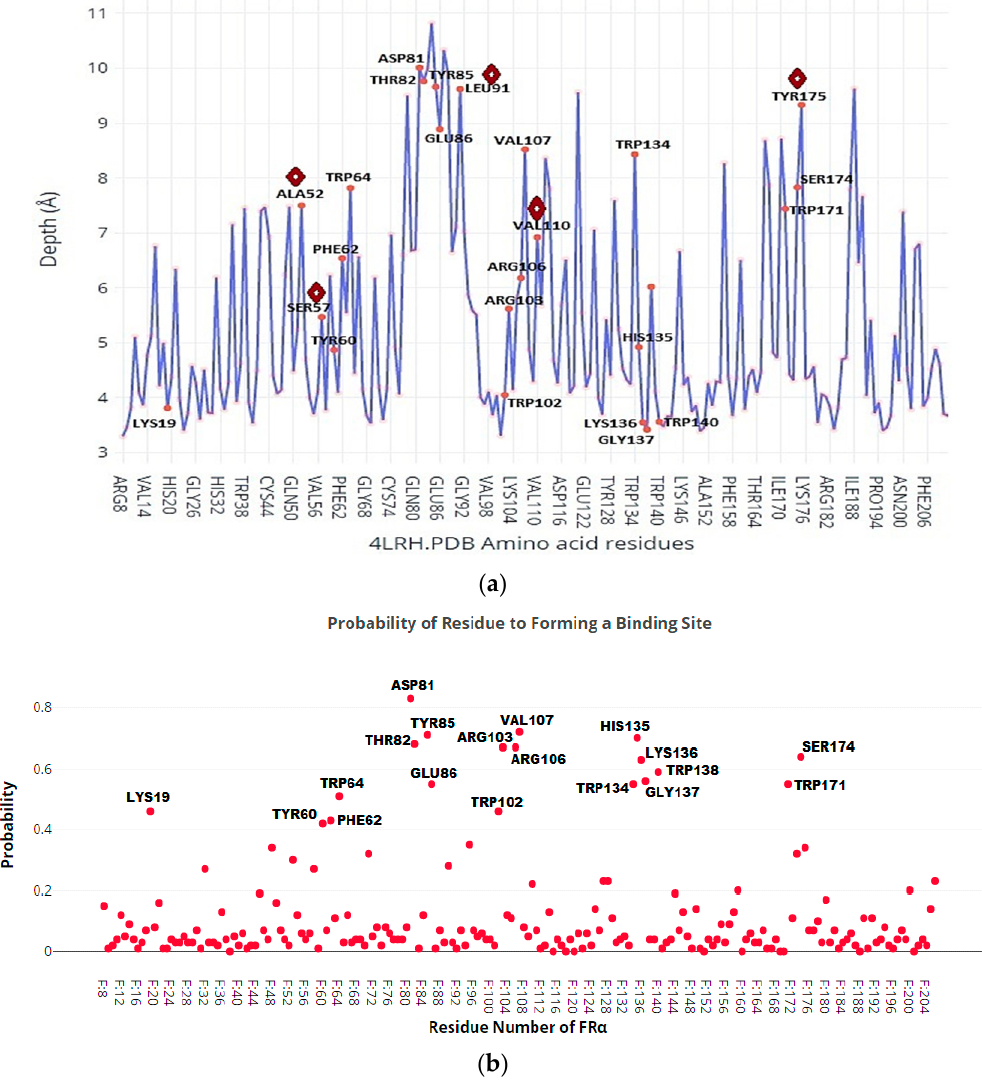
Figure 3. The amino acids existing in the depth of the pocket using Depth test. ( a ) Unpredictable residues by depth server and confirmed by P2Rank server to form FR α active site. ( b ) The probability of amino acids, which exist in the binding pocket, forming the binding site.